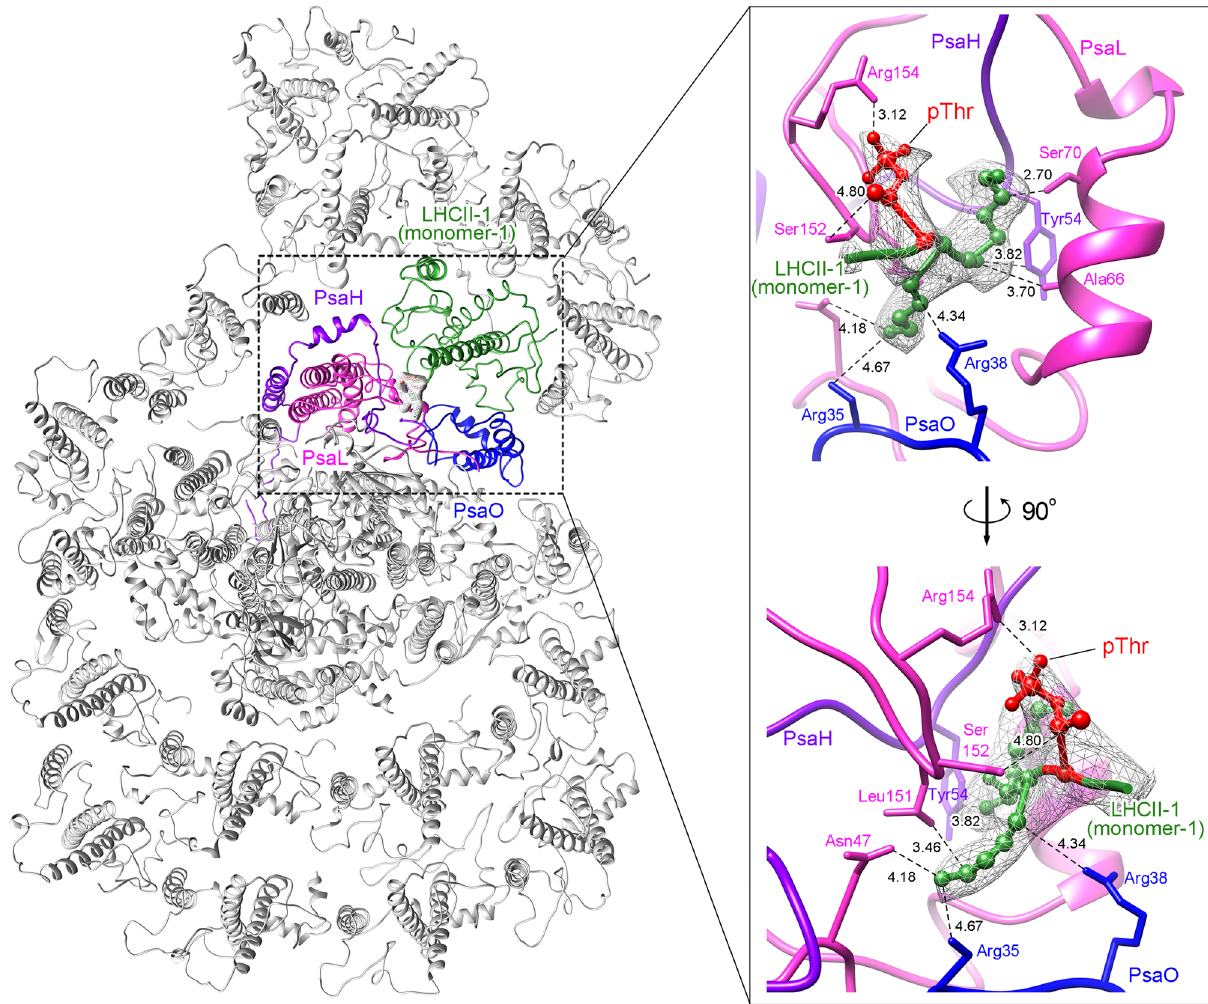
Fig. 5 The structure of the phosphorylation site of LHCII and its interactions with the PSI core subunits of C. reinhardtii . The LHCII residues involved in the interactions with PSI core subunits are shown in ball and stick, and the densities of these residues are shown as gray meshes, in the right-side panel. The residues of PSI core subunits involved in the interactions with the phosphorylated LHCII are shown as sticks. The dashed lines indicate hydrogen bonds or van der Waals interactions between adjacent groups. The distances (Å) between two connected atoms are labelled nearby the dashed